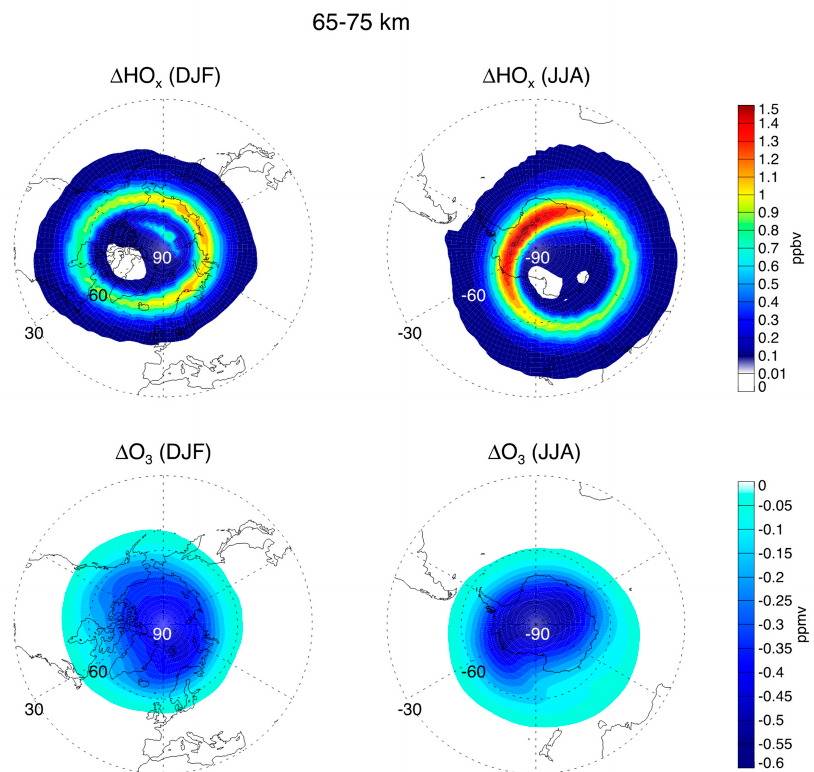
Figure 4. The differences (MEE-Control) of the mean HOx and ozone are presented in the altitude range of 65–75 km in the northern winter (December, January, February; DJF) and southern winter (June, July, August; JJA) during the period from 2005 to 2013.